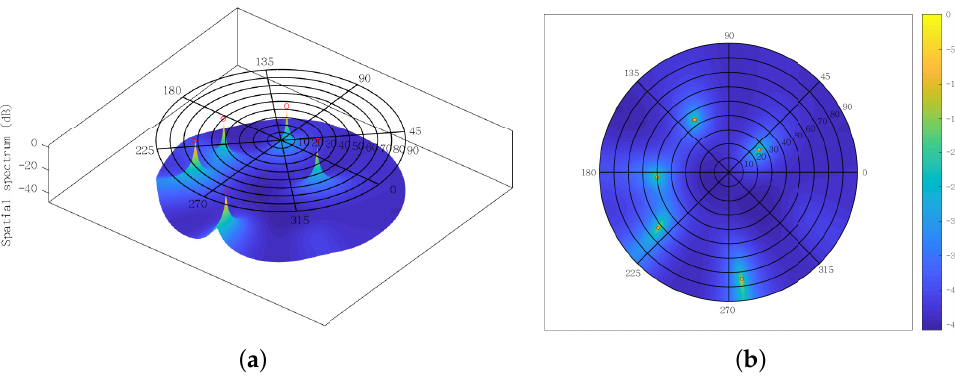
Figure 14. Spatial spectrum using SUMC estimator for solving four sources, SNR = 15 dB, K = 1024: ( a ) front; ( b ) top.